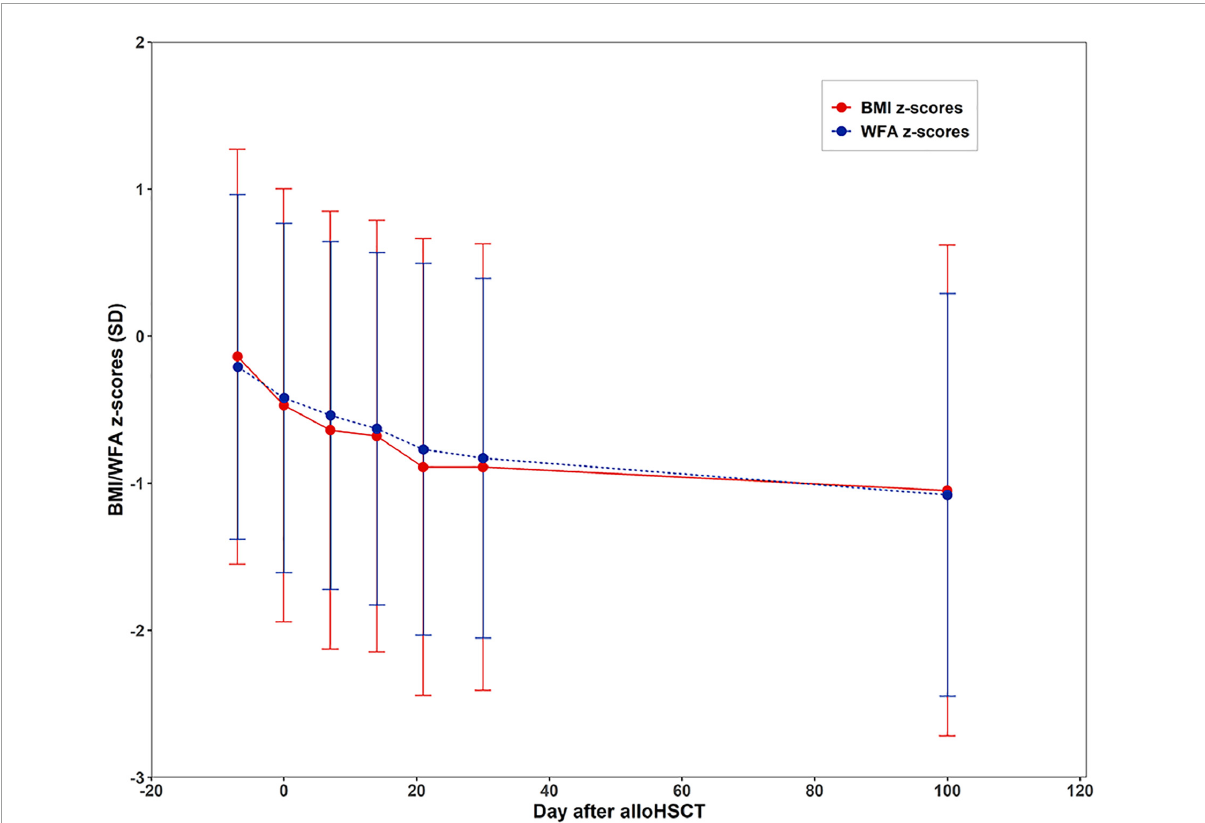
FIGURE1 Changes of mean body mass index (BMI) z-scores and weight for age (WFA) z-scores during treatment of alloHSCT (at initial admission and the day of transplantation, day + 7, day + 14, day + 21, day + 30, and day + 100 after HSCT).